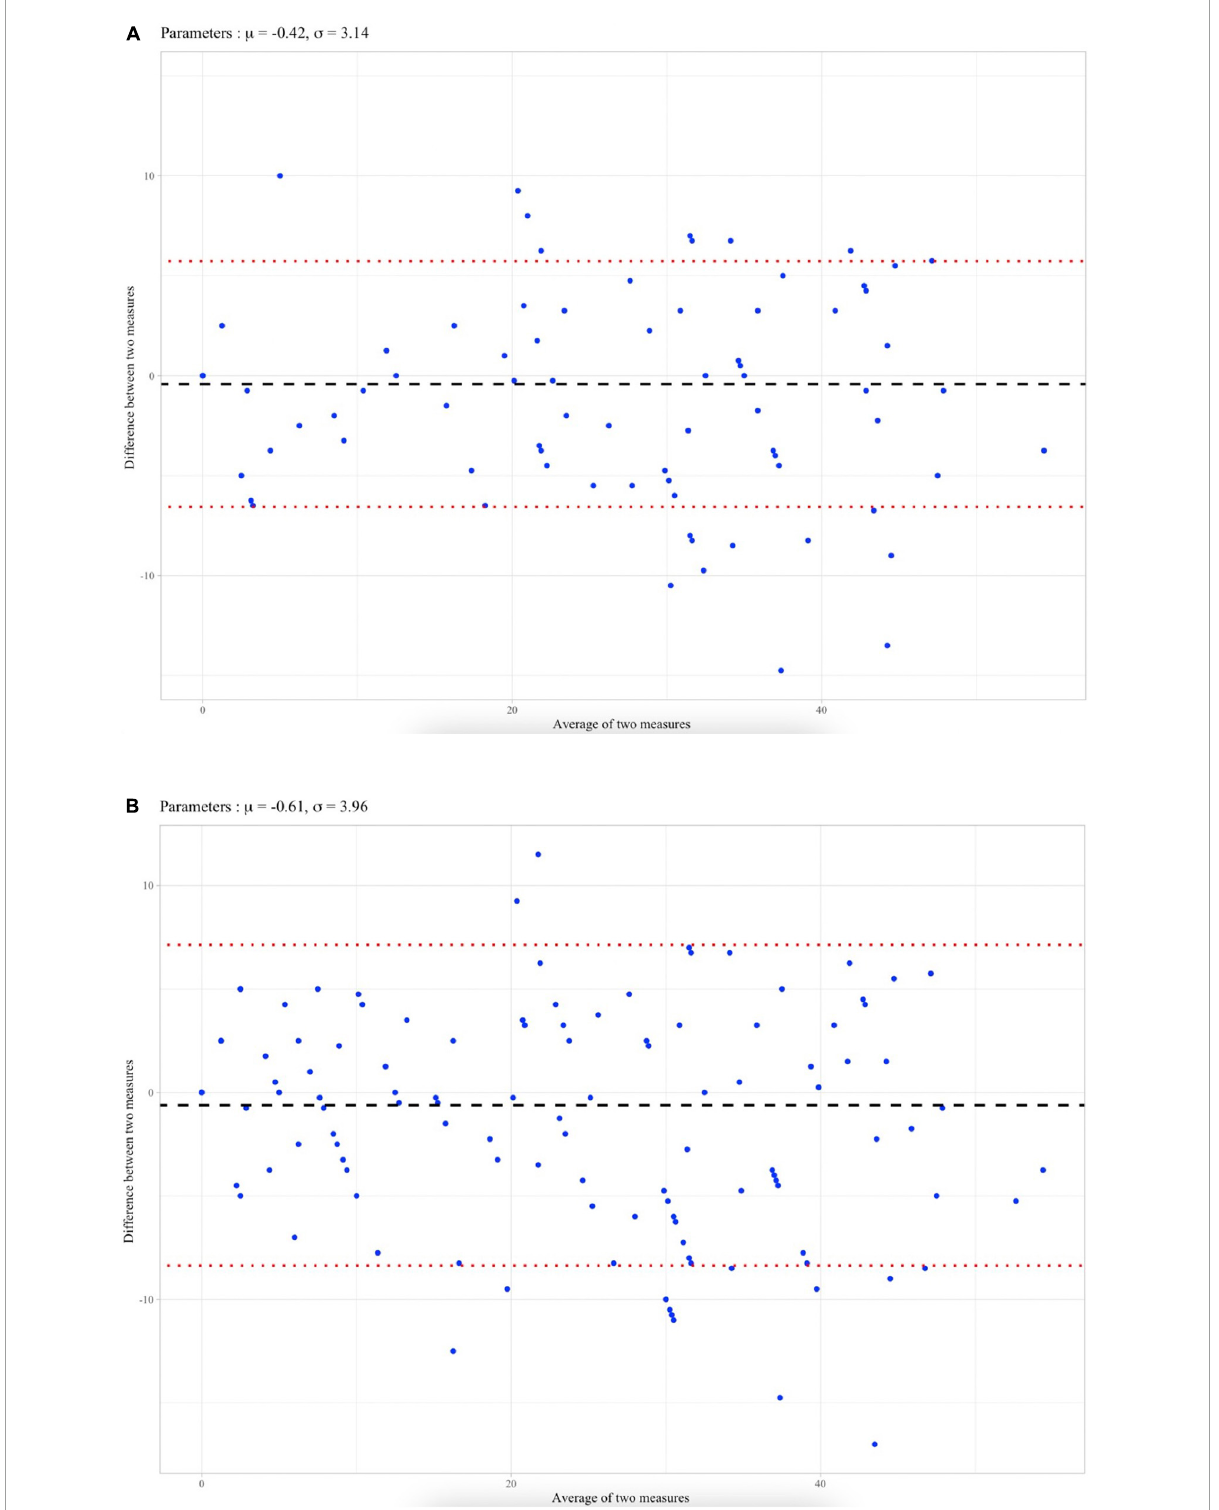
FIGURE2 (A) Bland et Altman plot analysis for mismatched perfusion defect with mean difference ( µ ) and standard-deviation ( σ ). Limits of agreements were defined as µ ± 1.96 ∗ . (B) Bland et Altman plot analysis for perfusion defects regardless ventilation with mean difference ( µ ) and standard-deviation ( σ ). Limits of agreements were defined as µ ± 1.96 ∗ σ